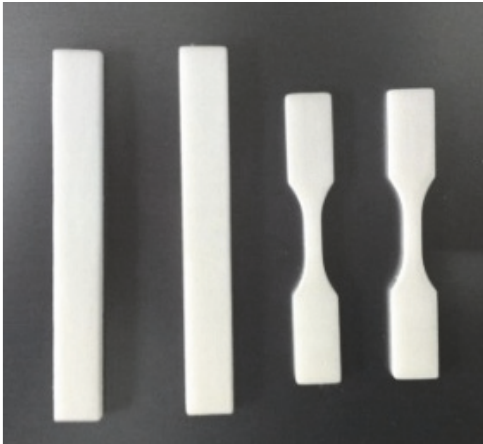
Figure 9: Sintering samples.